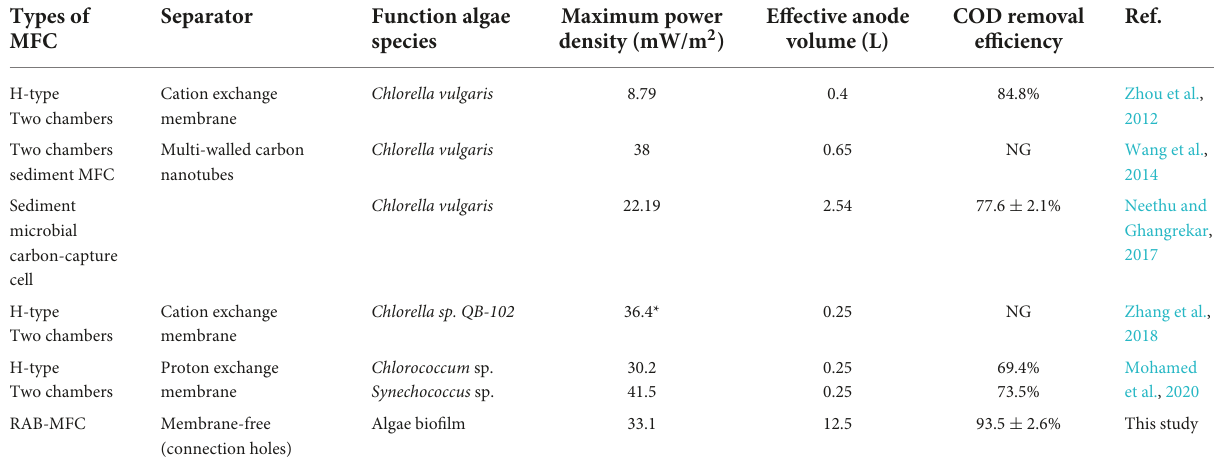
TABLE 1 Comparison of algae-based cathode MFC system